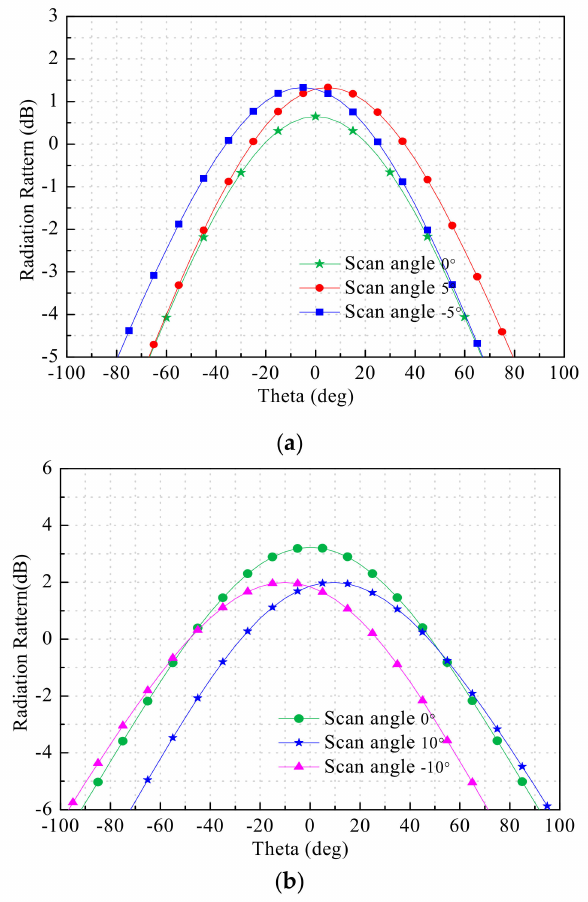
Figure 3. Simulated radiation patterns ( ϕ = 0 ◦ plane) with di ff erent high impedance units at 0.5 THz. ( a ) θ = 0 ◦ ( m = 0) and θ = ± 5 ◦ ( m = 3). ( b ) θ = 0 ◦ ( m = 12) and θ = ± 10 ◦ ( m =